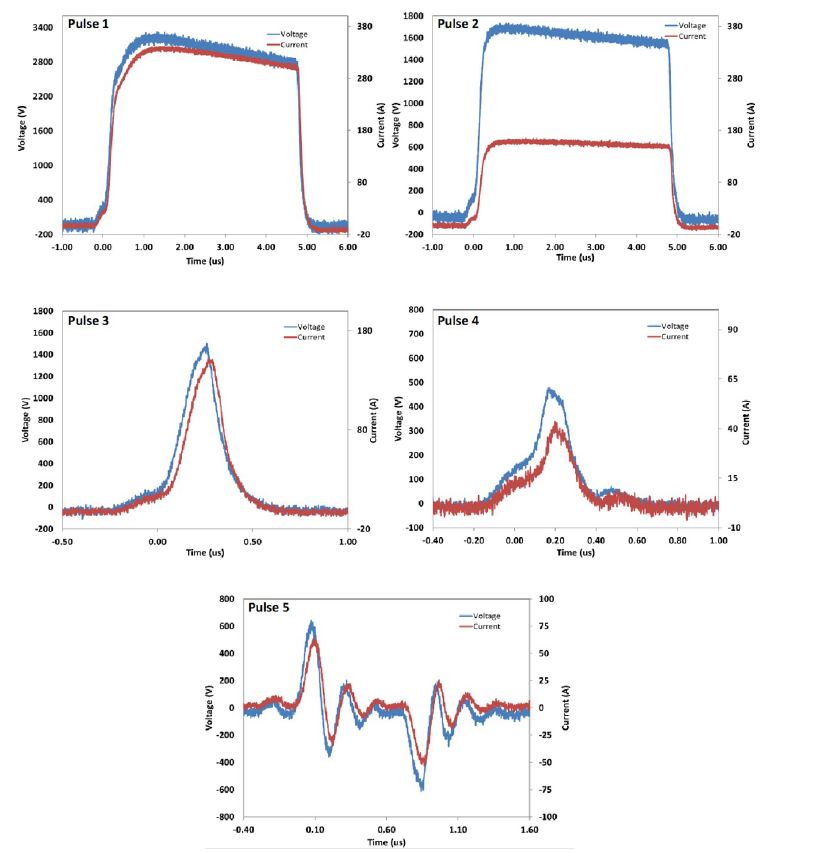
Fig 1. Pulse Electric Field (PEF) conditions used in this